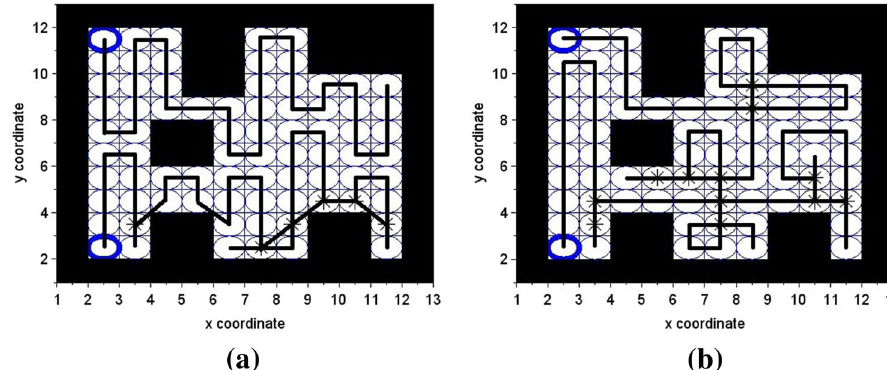
Fig. 13 Comparison with Sun’s algorithm with two robots: a Sun’s algorithm [30]; b pro- posed algorithm